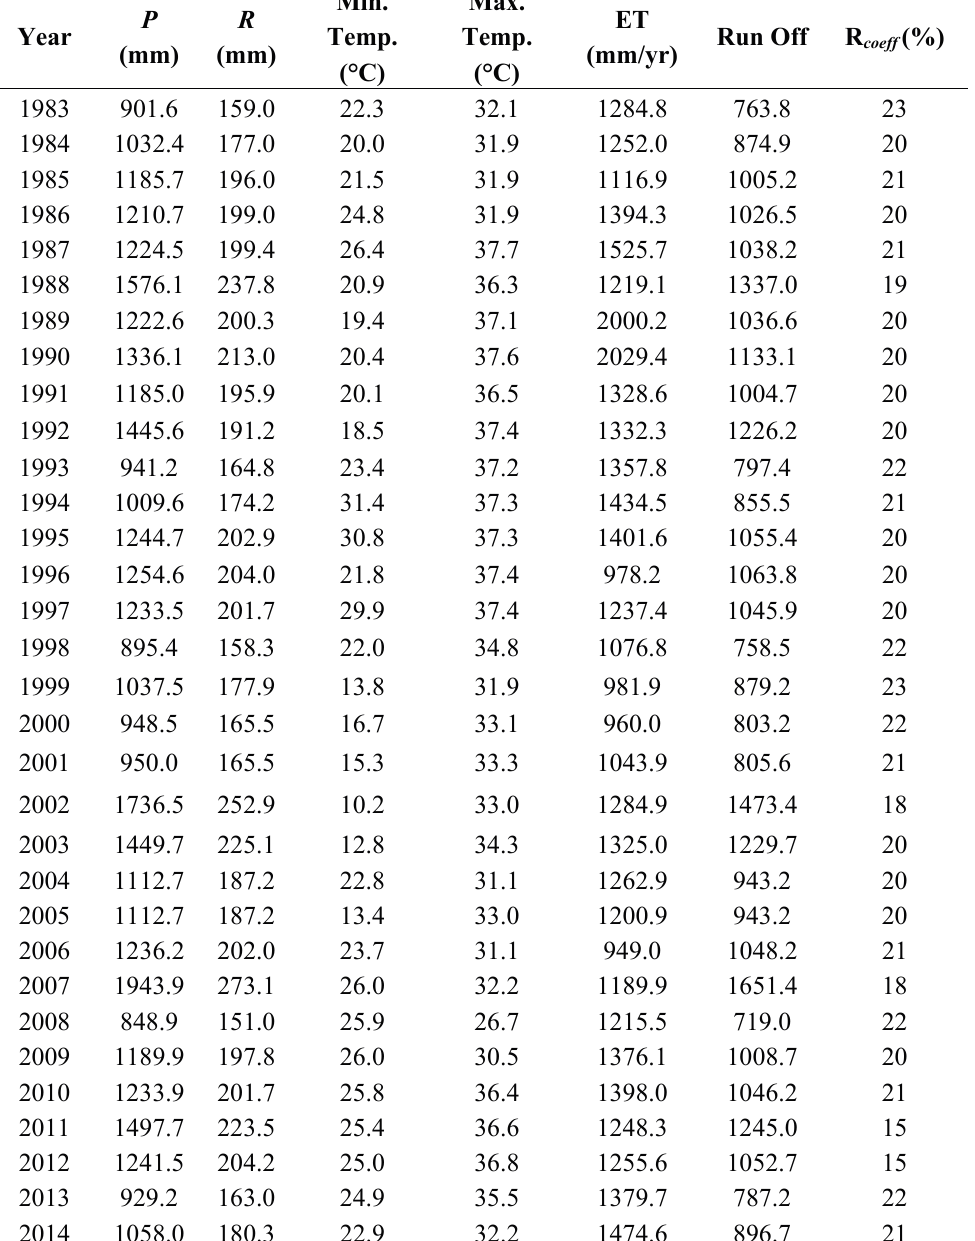
Table 1. Hydrological data of the study area for 32 years (1983 to